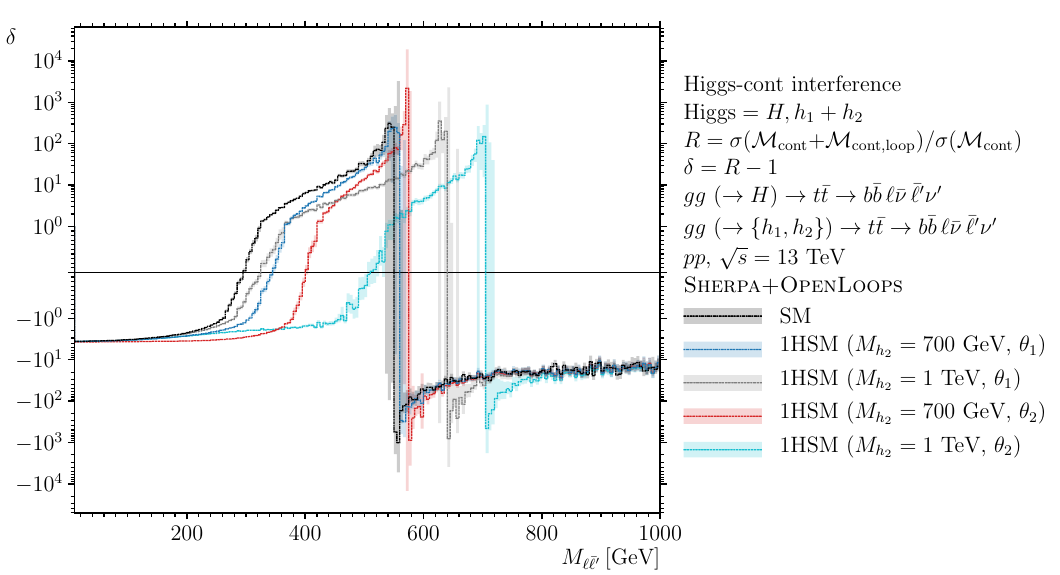
1 of the Higgs interference with the −